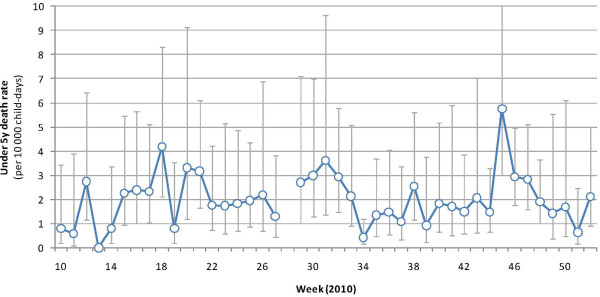
Under-5 death rate by week, 2010. Vertical bars represent 95% CIs.